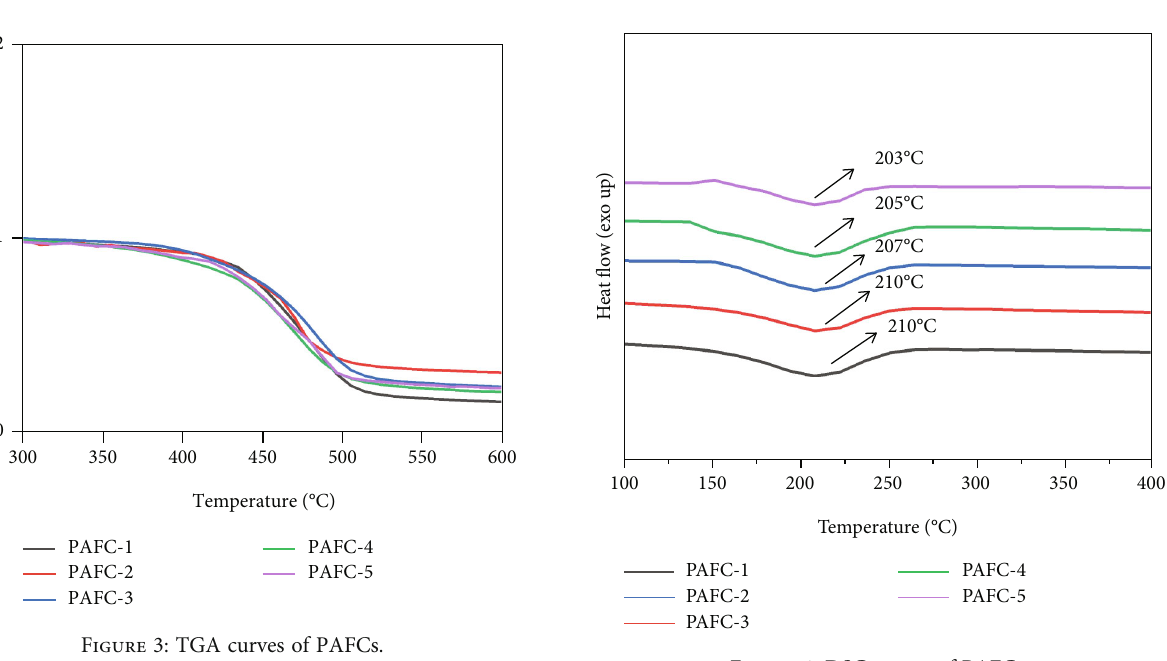
Figure 4: DSC curves of